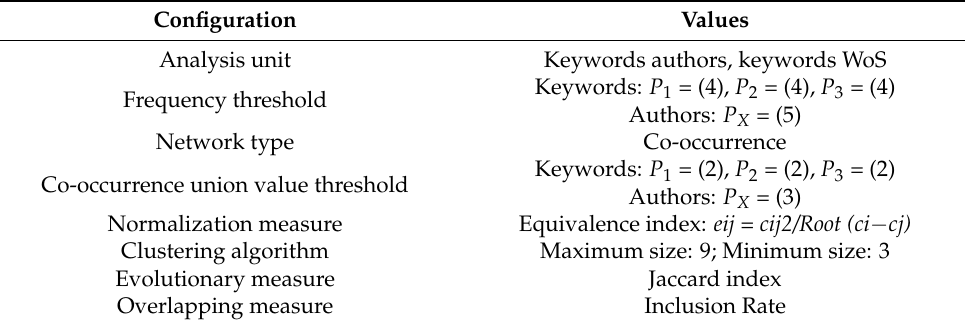
Table 1. Production indicators and inclusion criteria.